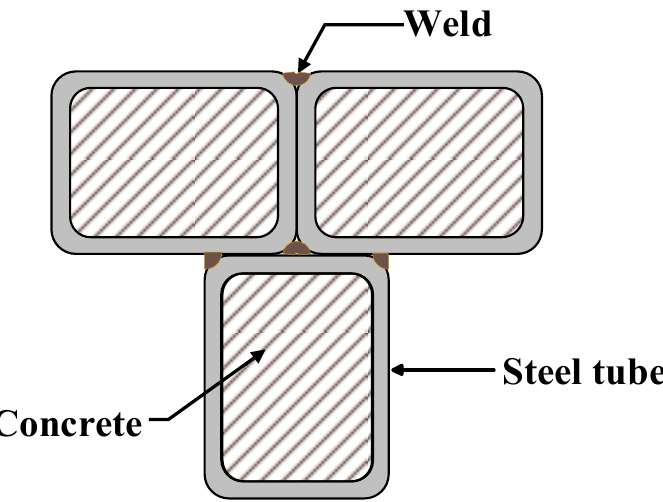
Figure 1. A typical MT-CFST cross-section.